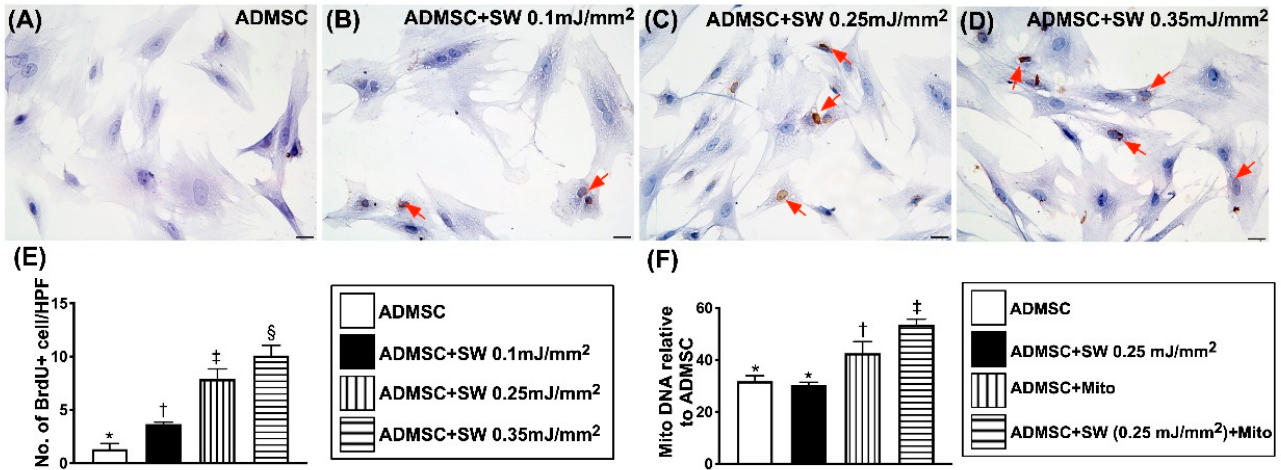
Figure 2. ECSW therapy enhanced ADMSCs proliferation and ECSW-assisted exogenous mitochondria transferred into recipient ADMSCs. ( A – D ) Illustrating microscopic finding (400 × ) of immunohistochemical (IHC) stain for identifying a progressively increased appearance of BrdU uptake (gray color) (red arrows) after a stepwise increase in dosages of ECSW energy. Scale bar in right lower corner represents 20 µ m. ( E ) Number of BrdU expression per higher-power field (HPF), * vs. other groups with different symbols (†, ‡, §), p < 0.0001. ( F ) Gene expression of ADMSC mitochondrial DNA among the groups, * vs. other groups with different symbols (†, ‡), p < 0.0001. All statistical analyses were performed by one-way ANOVA, followed by Bonferroni multiple comparison post hoc test ( n = 6 for each group). ADMSCs = adipose-derived mesenchymal stem cells; SW = shock wave.